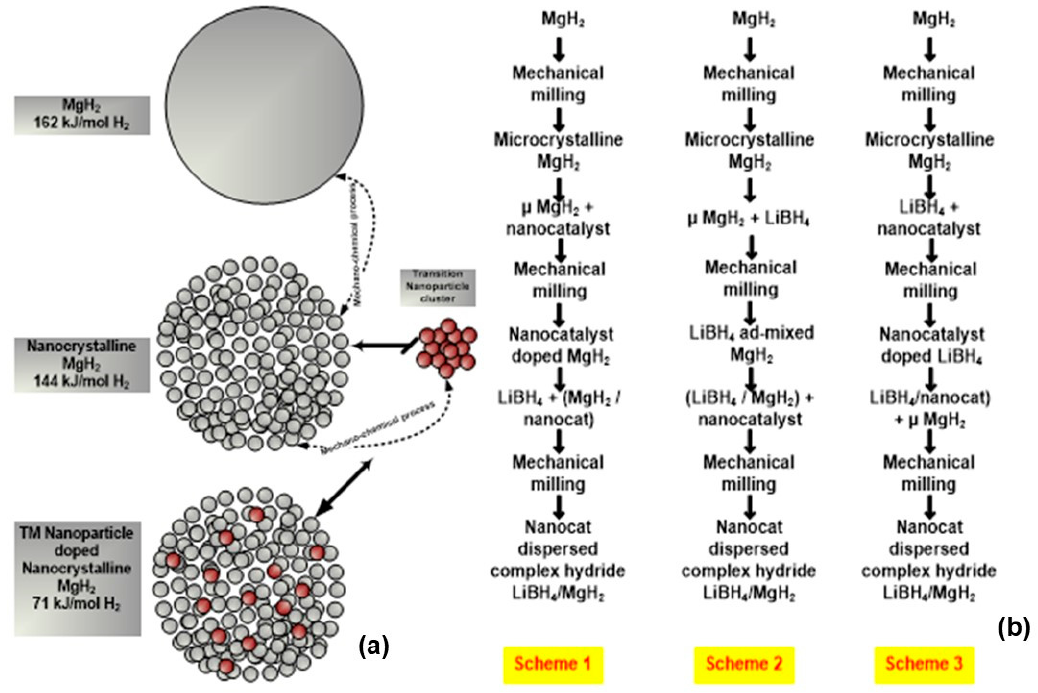
Figure 10. ( a ) Conceptual model and ( b ) flowchart for the reaction pathway schemes of the plain, nanocrystalline, and nanocatalysts doped nanocrystalline LiBH 4 / MgH 2